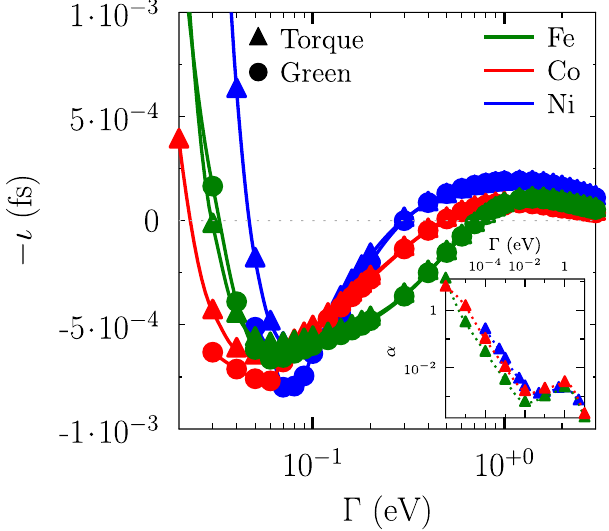
Figure 2. Moment of inertia ι as a function of the broadening of the quasiparticle spectral function Γ for bcc Fe (green dotes and lines), fcc Co (red dotes and lines), and fcc Ni (blue dotes and lines) and with two different methods: ( i ) the torque-torque correlation method (filled triangles) and the ( ii ) Greens function method 32 (filled circles). The dotted grey lines indicating the zero level. The insets show the calculated Gilbert damping α as a function of Γ . Lines are added to guide the eye. Notice the negative sign of the moment of inertia.